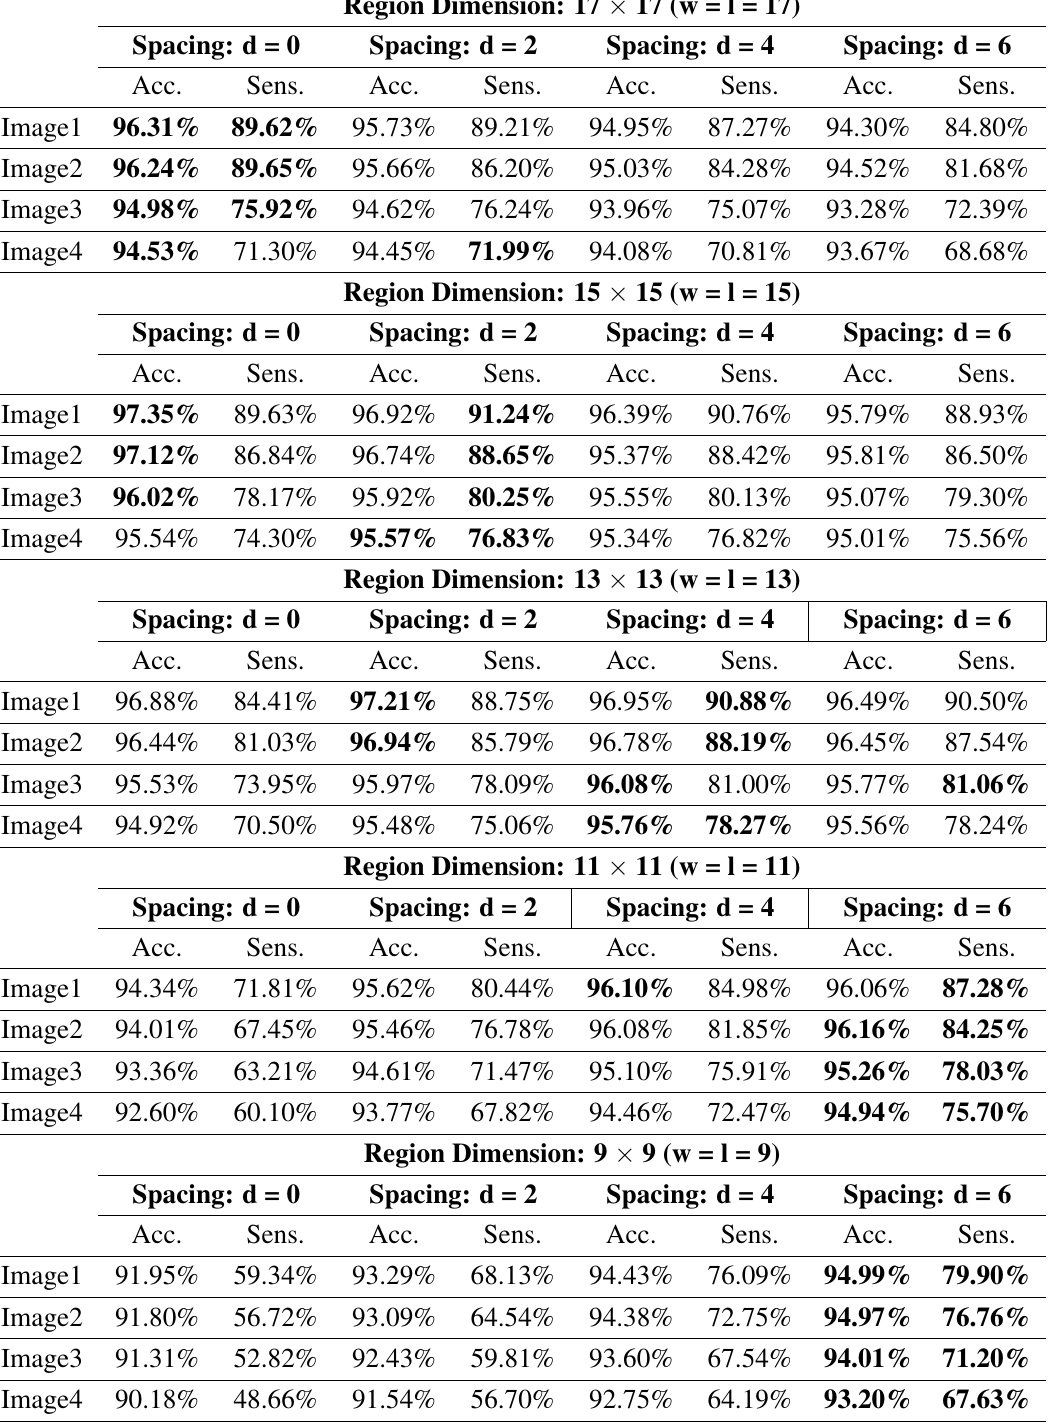
Table 3. Modified ANOVA: sensitivity and accuracy values evaluated on the four synthetic images with varying window and spacing